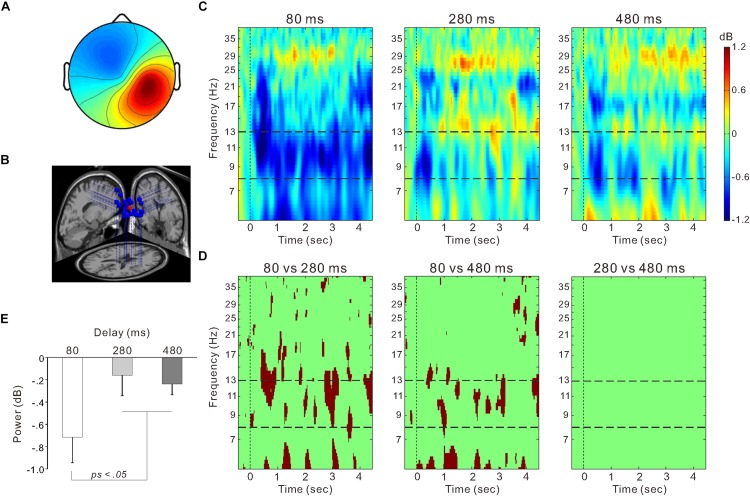
The right sensorimotor cluster. (A) Scalp topographical map. (B) Estimated dipole locations for each participant (blue) and their centroid locations (red). (C) Event-related spectrum perturbation (ERSP) time-frequency plots for the 80-ms (left), 280-ms (middle), and 480-ms delay conditions (right). Blue color indicates decreased power and red color indicates increased power. The band between two horizontal dashed lines indicates the mu-rhythm frequency range (i.e., 8–13 Hz). (D) Statistically significant differences in time-frequency plots (p < 0.01) between the 80 and 280-ms delay conditions (left), between the 80 and 480-ms delay conditions (middle), and between the 280 and 480-ms delay conditions (right) using the bootstrap method and false discovery rate correction. (E) Mean power within the 8–13 Hz frequency range from the onset of model hand movement to 4 s post-onset in each delay condition. Vertical lines denote standard error of the mean (SEM).